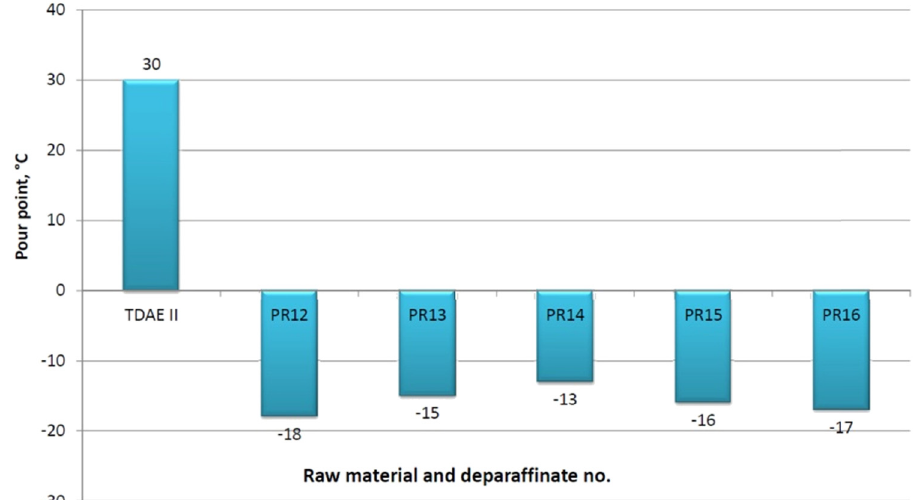
Figure 7: E ff ect of the dewaxing process with the MEK – MTBE solvent on the change of the depara ffi nate pour point – TDAE II raw